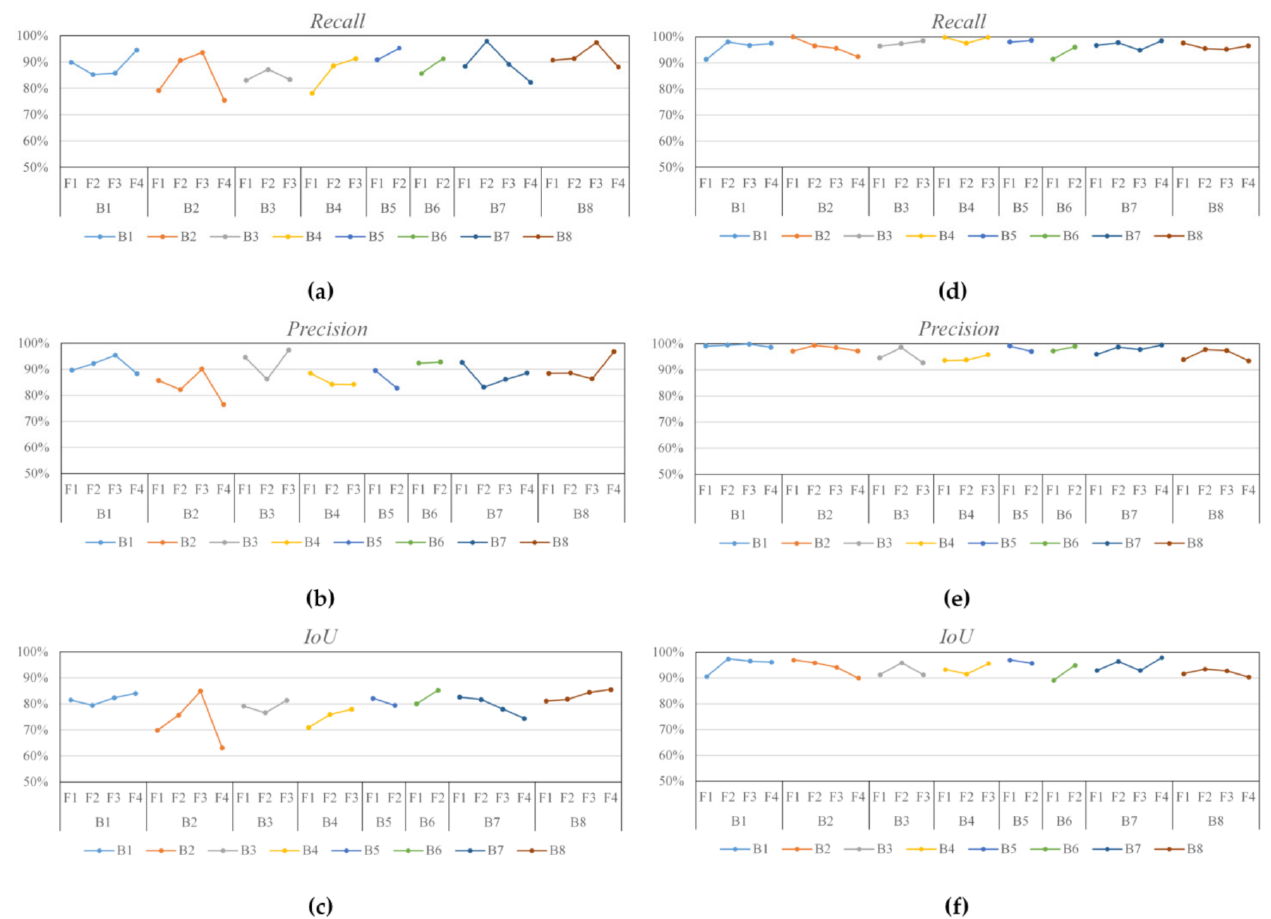
Figure 9. Comparisons of Recall, Precision, and IoU values calculated from the public images corre- sponding to the three untextured and five textured models shown in Figures 7 and 8. ( a – c ) are the Recall, Precision, and IoU values obtained by point-based quadrilateral-region detection. ( d – f ) are the Recall, Precision, and IoU values obtained by point-line-based quadrilateral-region detection. B1–B8 indicate the number of building models, and F1–F4 indicate the façades of building